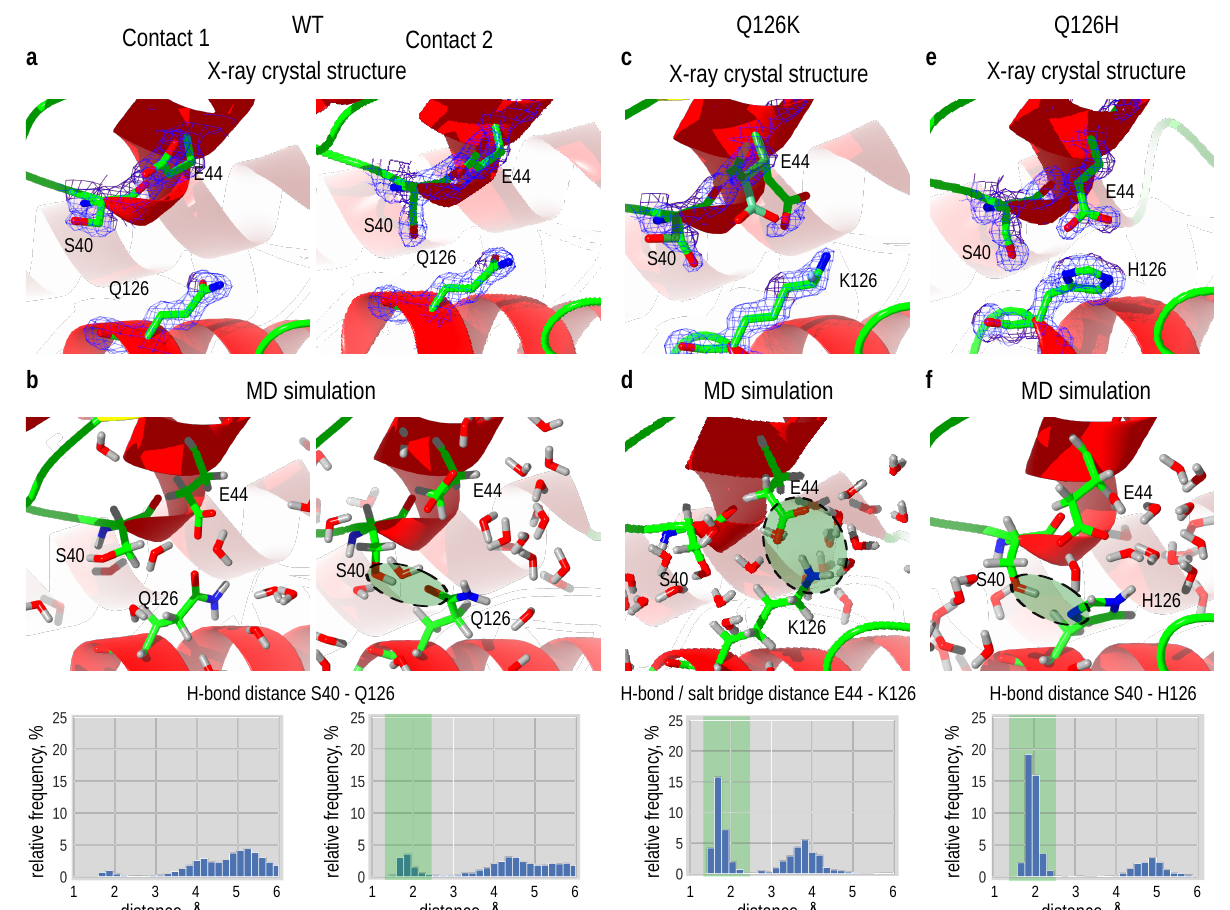
Figure 5. X-ray crystallography structure and MD simulation analysis of the corner contact around amino acid position 126 for wild type Lb ADH, Q126K, and Q126H crystals. ( a ) X-ray crystallography structure of corner crystal contacts 1 and 2 in wild type crystals with measured electron density map shown in blue for displayed residues. ( b ) MD simulation and analysis of bonding distance between hydroxy hydrogen of serine (S40) and amide oxygen of glutamine (Q126). In contact 1, almost no hydrogen bond (H-bond) interactions (0.77 ± 0.43% of the simulation time) could be found. In contact 2, for 16.80 ± 8.11% of the simulation time an H-bond existed. H-bond distance (<2.5Å) is dyed green. ( c ) X-ray crystal structure of Q126K. Different side chain conformations are displayed in different shades. ( d ) MD simulation revealed an H-bond/salt bridge between positively charged ammonium group of lysine (K126) and negatively charged carboxylate group of glutamate (E44) in 66.0 ± 7.7% of the time. ( e ) X-ray crystal structure of Q126H. ( f ) The most stable H-bond could be found in Q126H between imidazole nitrogen of histidine (H126) and hydroxy hydrogen of serin (S40), which was present for 74.3 ± 7.3% of the time. Note: As Q126K and Q126H diffract in space group I 222, “contact 1” and “contact 2” coincide. Electron density maps are calculated with structure factor amplitude difference 2F o − F c and contoured at 1.0 σ